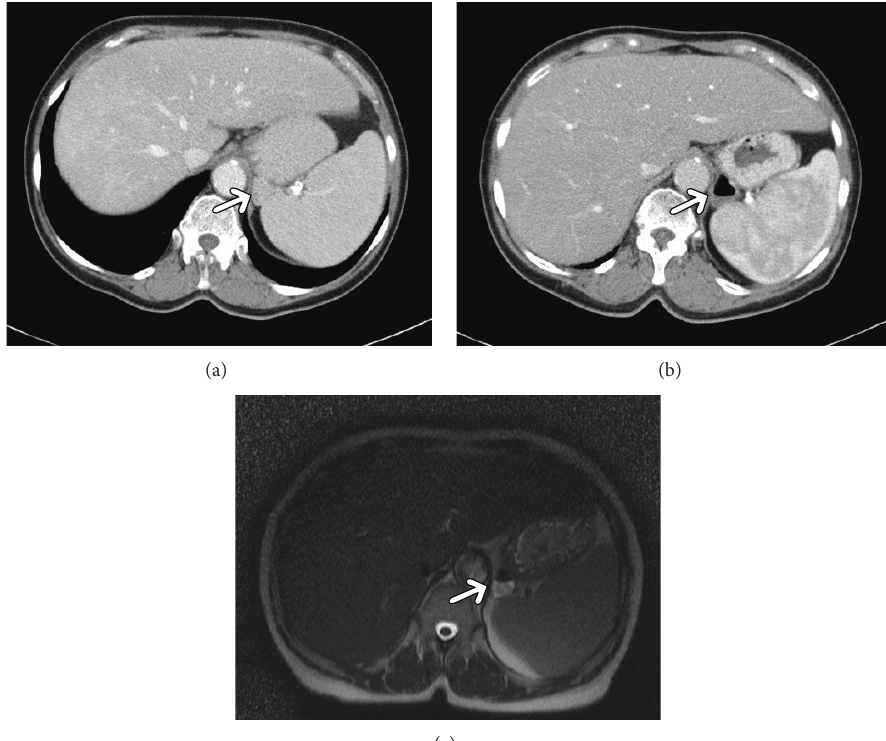
Figure 2: Imaging findings in a 70-year-old woman with known history of hepatocellular carcinoma. (a) Primary computer tomographic scan detecting a solid mass between the stomach aorta and spleen (arrow). The lesion was interpreted as an accessory spleen. (b) On computer tomographic scan 5 months after the primary investigation the lesion is cystic with air fluid level (arrow). (c) MRI image of the lesion (arrow). junction. The mean size of GD was 21.7 ± 10.9 mm (median size, 20 mm; range, 7–45 mm) in left-right (transversal) and 31.7 ± 18.9 mm (median size, 26 mm; range, 10–75 mm) in anterior-posterior (sagittal)